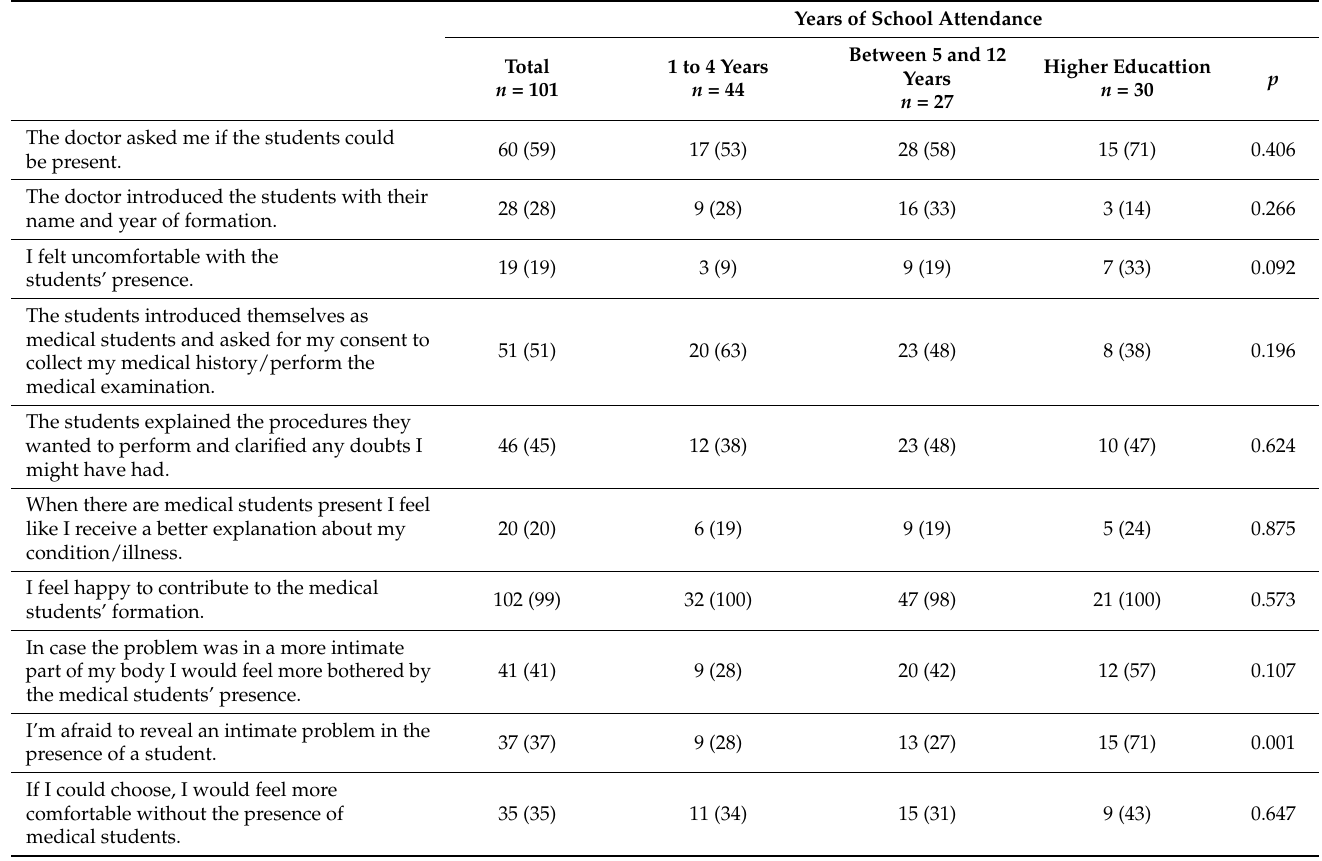
Table 3. n (%), of answers to the questions regarding the presence of medical students on a previous consultation and/or hospital admission according to patients’ level of education. Years of School Attendance Between 5 and 12 Total 1 to 4 Years Higher Educattion p Years n = 101 n = 44 n = 30 n = 27